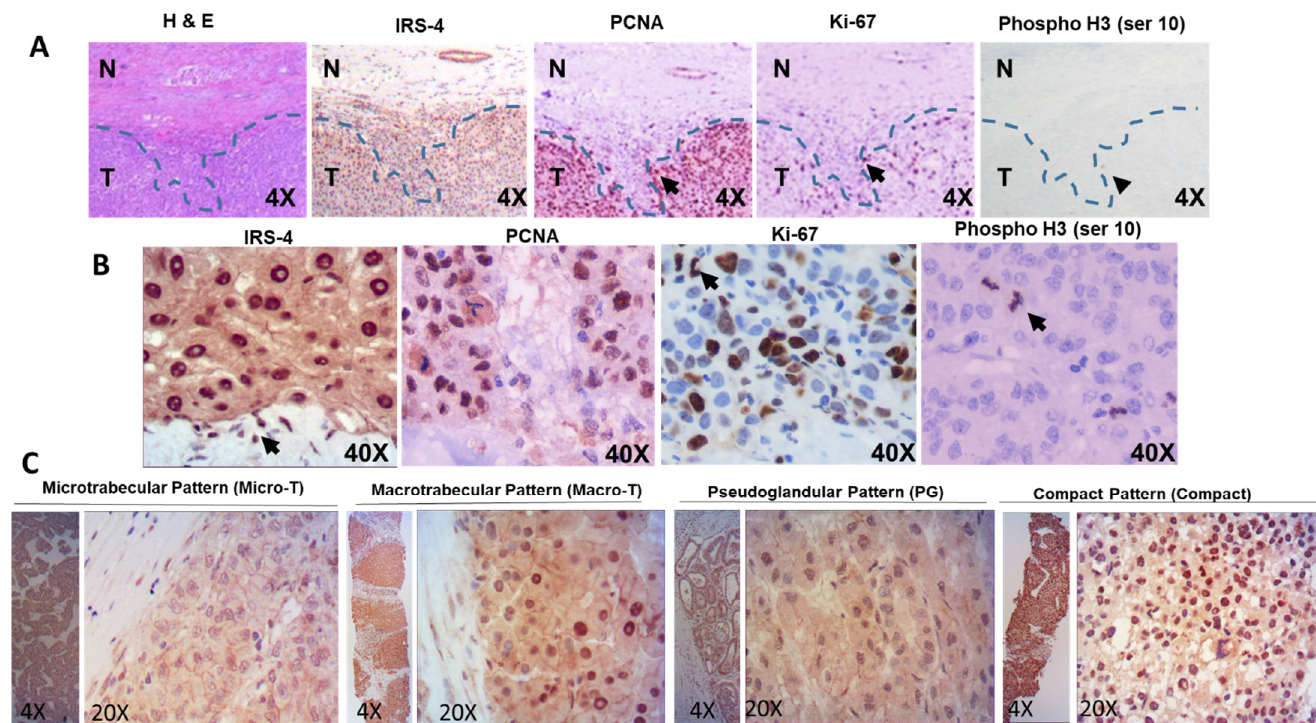
Figure 2. Immunohistochemical staining of IRS-4, PCNA, Ki-67, and pH3 ( A , B ). Immunohistochemical staining of IRS-4 in different architectural patterns of HCC ( C ). H&E = hematoxylin and eosin staining.